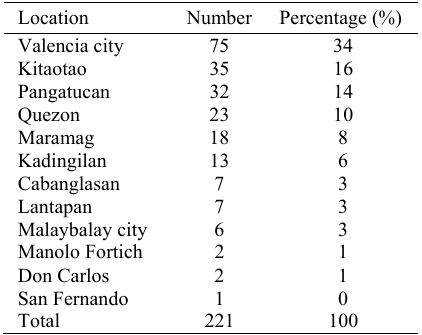
Table 2: Location of species occurrence points